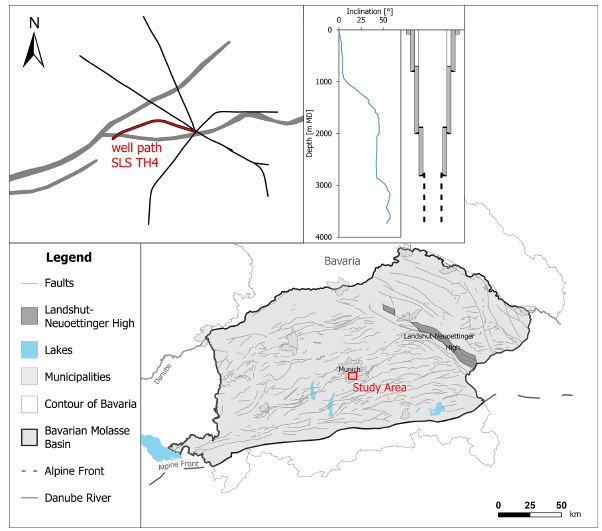
Figure 1. Map of the Bavarian Molasse Basin, cropped to Bavaria, and the six well paths at the geothermal study site Schäftlarnstraße with inclination and scheme of well completion of SLS